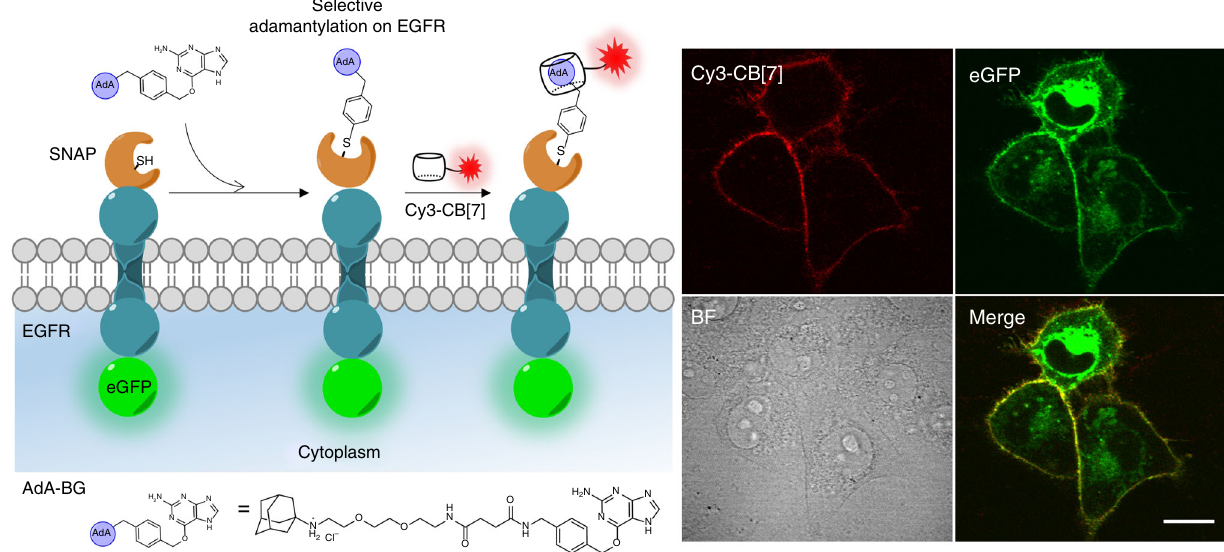
Fig. 7 Visualization of a target speci fi c protein. Schematic illustration of adamantylation on r-EGFR using SNAP-tag method. Confocal laser scanning microscopy images of COS7 cells which have SNAP and eGFP-tagged recombinant EGFR expressed in the plasma membrane. Scale bar = 20 μ m